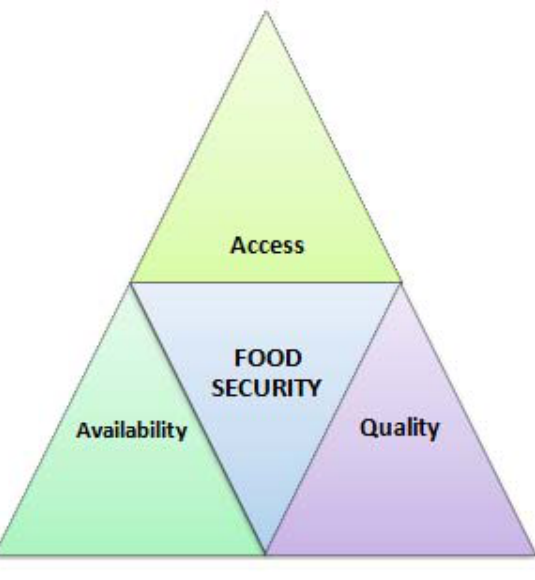
Figure 1. Conceptual model of food security